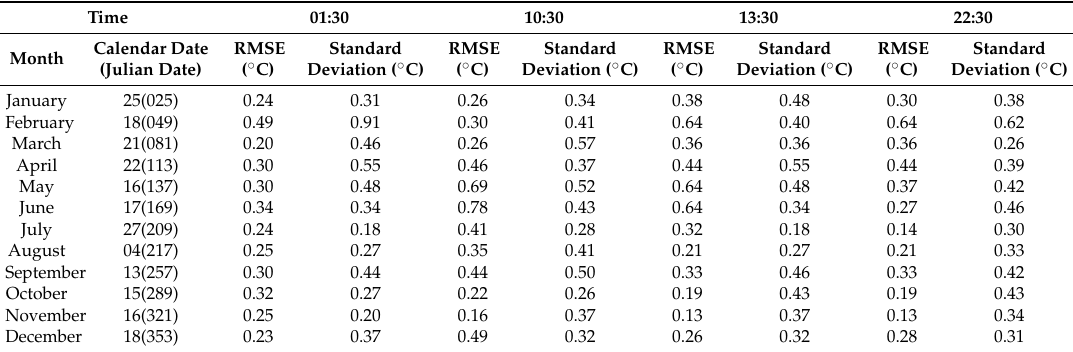
Table 3. The statistical summary of latent LST predictions for each month. Table 2. The statistical summary of latent LST predictions for each